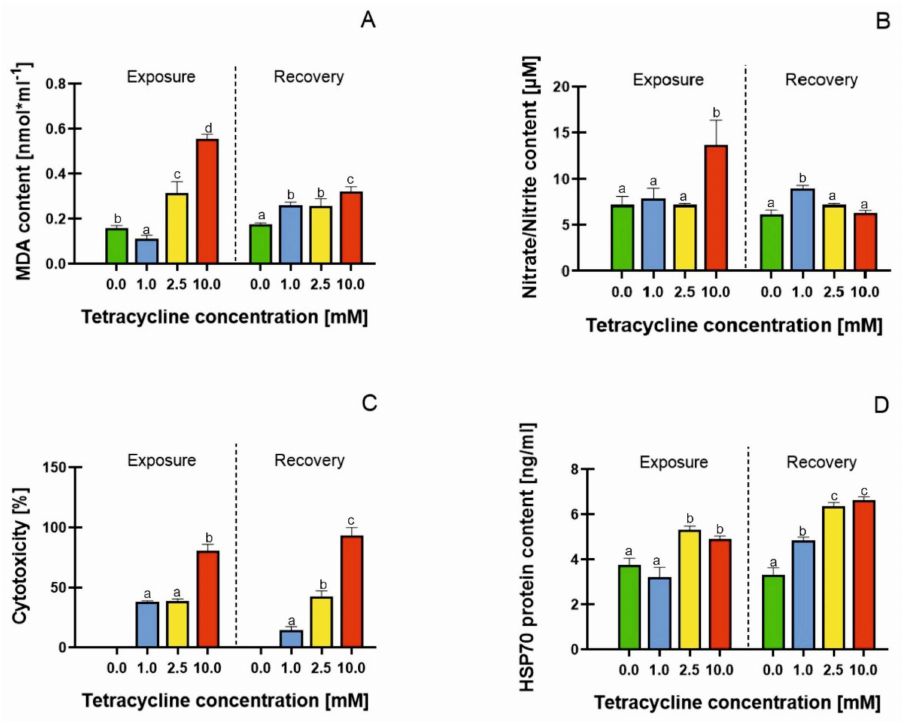
Figure 5. Malondialdehyde (MDA) content ( A ), cell membrane damage ( B ), mitochondrial cyto- toxicity ( C ), and HSP70 protein content ( D ) in Lemna minor subjected to tetracycline (exposure) and in the recovery phase (resumed growth after 7 days of culture in an antibiotic free medium). Means denoted with different letters are significantly different ( p ≤ 0.05) across the described groups: average ± standard